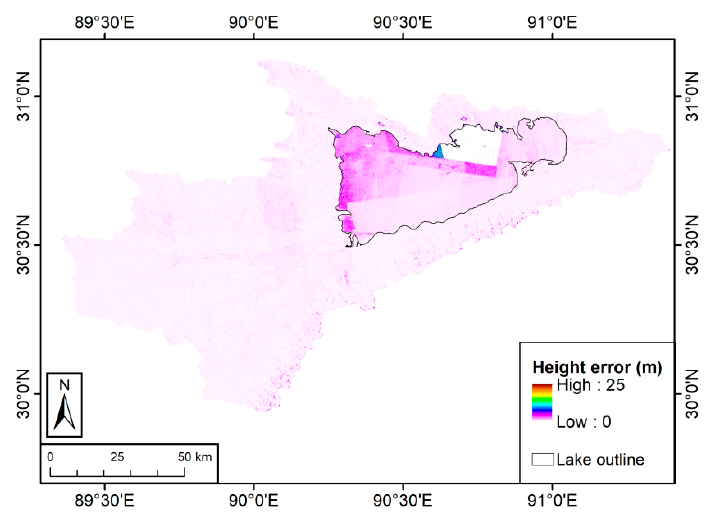
Figure 4. Quality Indicator as height error in meters of TanDEM-X 12 m DEM for Nam Co (©DLR 2017). The areas of the catchment that exhibit the highest interferometric coherence errors are the lake itself. The DEM has a maximum height error of 26.7 m, though 97.9% of the catchment had an error of <9.5 m. Furthermore, 79.3% of the area had an error of <0.5 m. 2% of the Height Error Map (HEM) values were unknown, invalid, or missing (the white section within the lake).